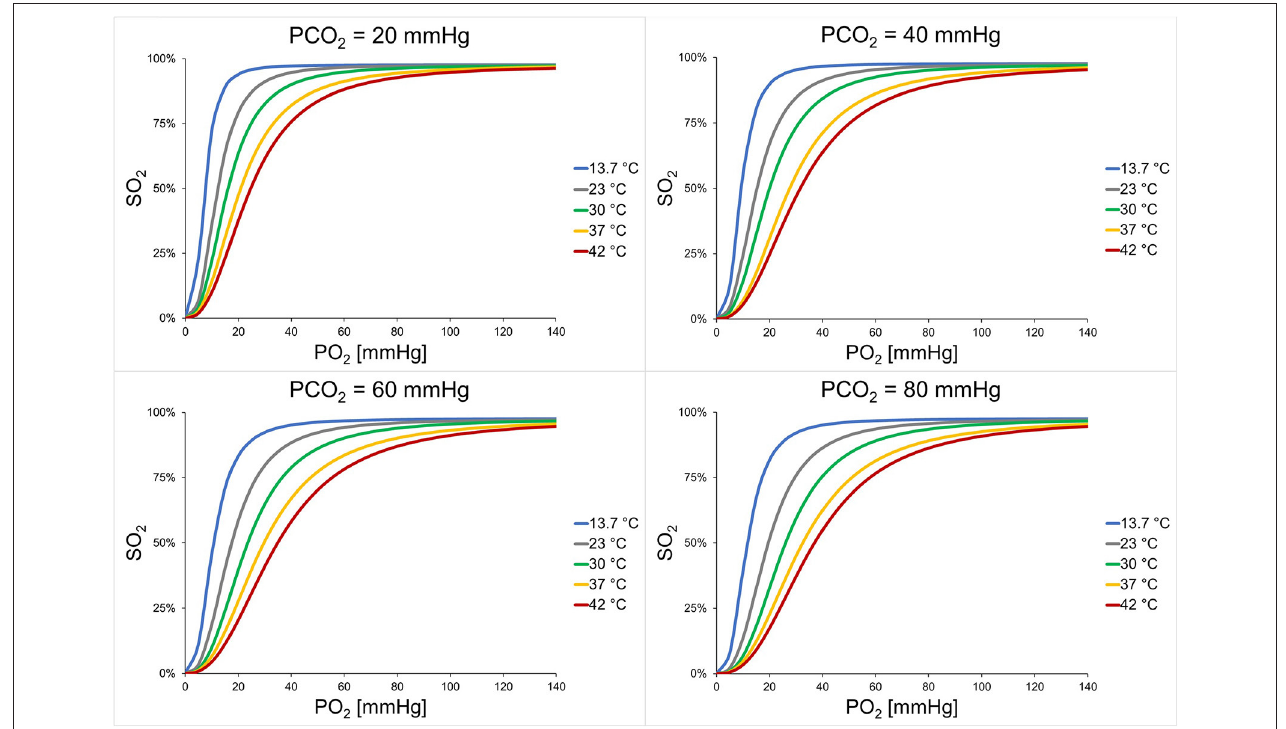
FIGURE 2 | Mean ODCs of all participants. The temperature effect is shown for each PCO 2 level. For each combination, mean P50s and mean Hill coefficient were inserted in the Hill equation [see Eq. 4 in ( 17)]. Each graph represents the mean of 30 participants and triplet measurements. P50, oxygen partial pressure at which 50% of hemoglobin is saturated with oxygen; SO 2, oxygen saturation; PCO 2 , carbon dioxide partial pressure.